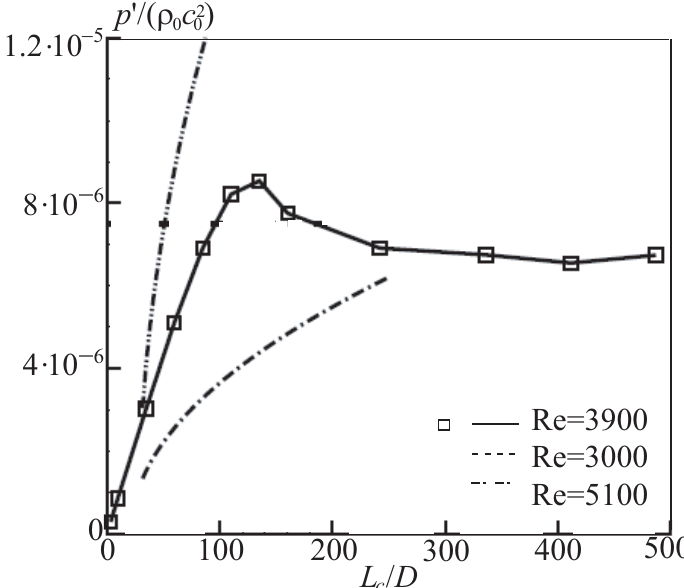
Figure 7. RMS pressure distributions depending on the length of the cylinder at θ = 90 ◦ for Re =